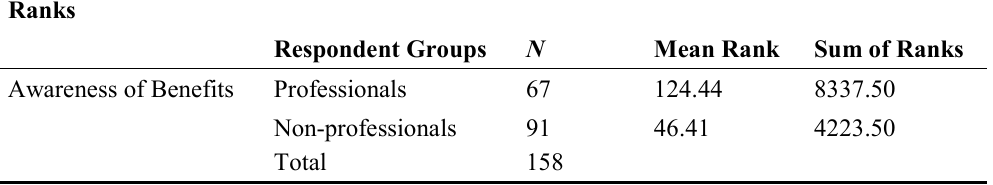
Table 5. Result of Mean Rank from Mann–Whitney U Test Ranks Respondent Groups N Mean Rank Sum of Ranks Awareness of Benefits Professionals